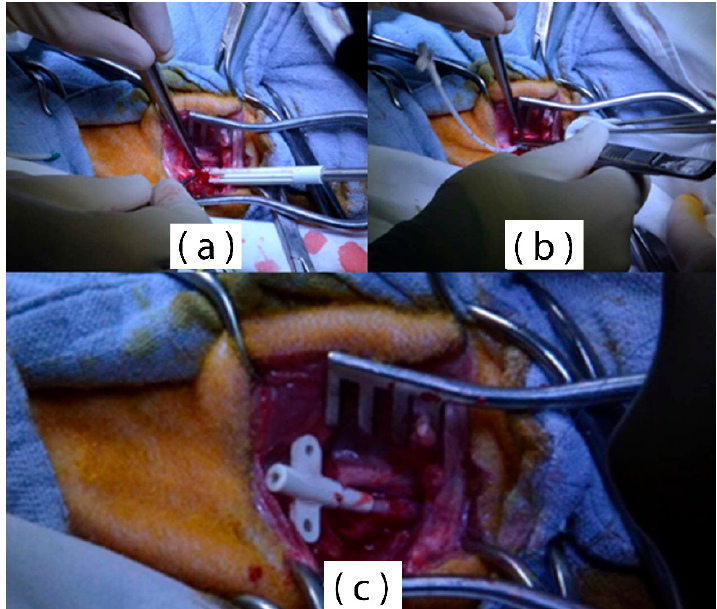
Figure 10. ( a ) Puncturing of the carotid artery; ( b ) insertion of the Parylene-C coated catheter; ( c ) catheter secured in the artery.